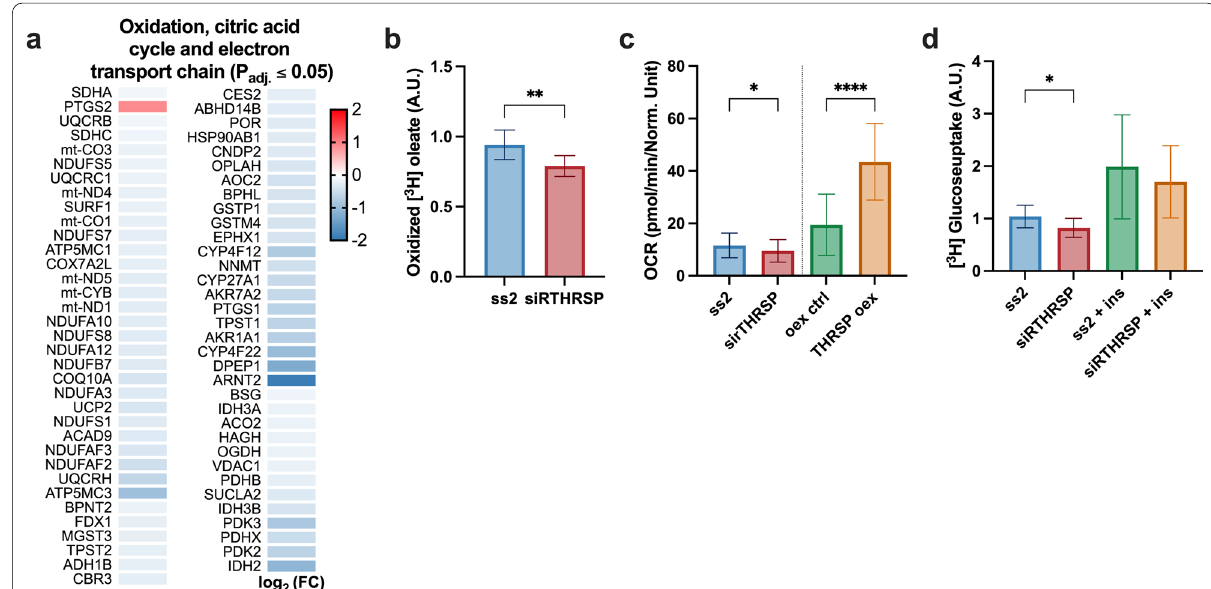
Fig. 4 Mitochondrial function is dampened by THRSP silencing in adipocytes. a Oxidation, citric acid cycle and respiratory electron transport associated genes were affected by THRSP silencing. The heatmap represents log 2 fold‑change (log 2 FC) of significantly altered genes (P adj b Oxidation of [ 3 H] oleate (n 9, two independent experiments). c Oxygen consumption rate (OCR) measured in control (ss2), THRSP silencing = (siR), overexpression control (oex ctrl) and overexpression (oex) (Two independent experiments with multiple replicates). d) Uptake of [ 3 H] glucose in THRSP silenced adipocytes with or without insulin (n 12, two independent experiments). Statistical significance is designated as *P = **P < 0.01, ****P <